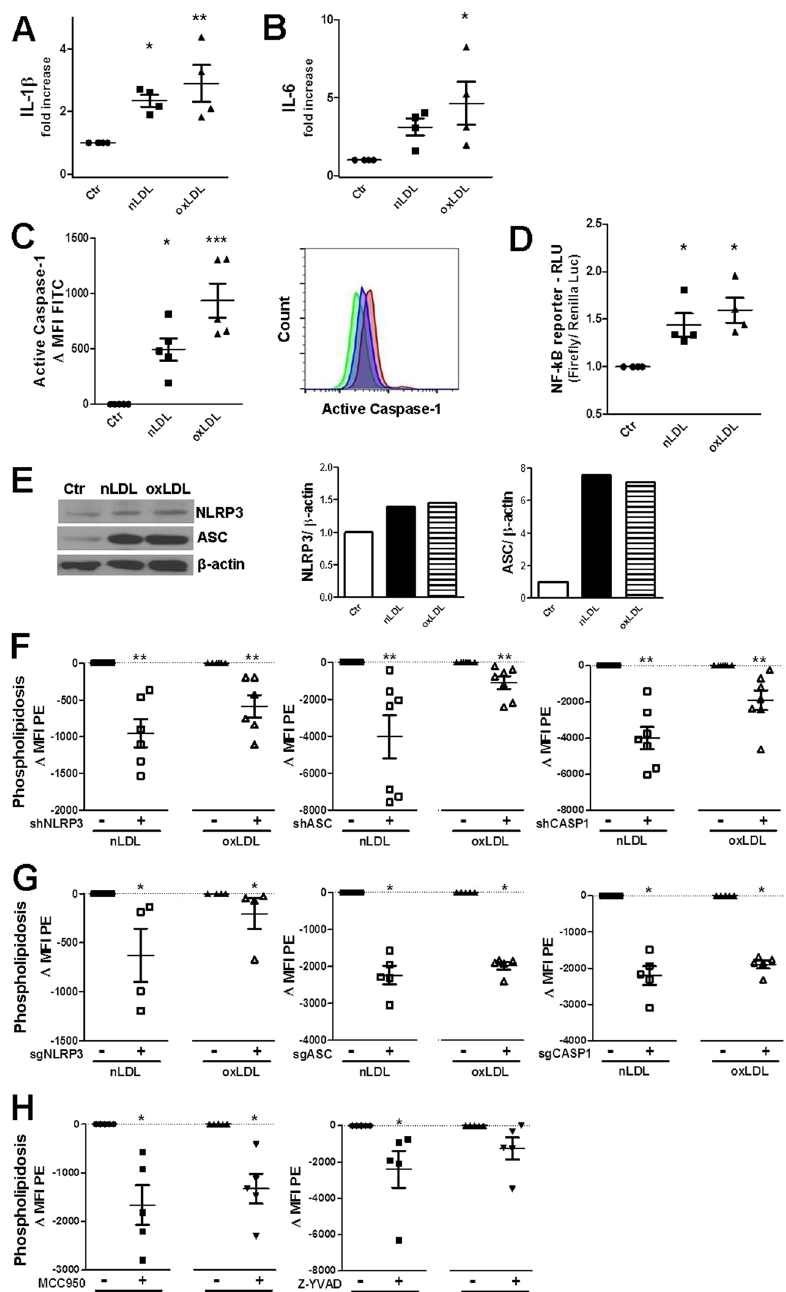
Figure 3. Activation of NLRP3 inflammasome during metabolic stress and regulation of phospholipidosis by the NLRP3/ASC/CASP1 complex. ( A ) Secretion of IL-1 β and ( B ) IL-6 by IM-PTEC (ELISA). Cytokine concentrations (pg/ml) relative to Ctr equal to 1. ( C ) FC-based detection of active caspase-1 in HK2 cells using the green fluorescent FAM-YVAD-FMK. FITC MFI Ctr values subtracted from all MFIs values. FITC peaks shown in the right histogramplot: green (Ctr), blue (nLDL), red (oxLDL). ( D ) Dual-luciferase assay measuring the activities of NF- κ B-driven Firefly luciferase (NF- κ B reporter vector) and Renilla luciferase (control construct) in cell lysates of transfected HK2 cells. Values show relative luminescence units (RLU):Firefly/ Renilla LU normalized to Ctr. ( E ) Westernblot for detection of NLRP3 and ASC in HK2 cells. Intensity normalized to β -actin loading control. Protein expression shown as fold increase compared to control equal to 1. ( F ) Phospholipidosis detection by FC after n/oxLDL loading in HK2 cells stably expressing lentiviral constructs encoding shRNA or ( G ) sgRNA targeting NLRP3, ASC, or CASP1 expression. Graphs showing the reduction in lipid storage in cells lacking full expression of the target gene in comparison to cells expressing the non-targeting sequence/empty vector. (H) Decline in fluorescence intensity emitted by LipidTox Red stained HK2 cells treated with NLRP3 (MCC950) and CASP1 (Z-YVAD-FMK) inhibitors (FC). (A–D , F , G ) Dots representing averages of independent experiments; mean ± SEM; * P < 0.05, ** P < 0.01, *** P <